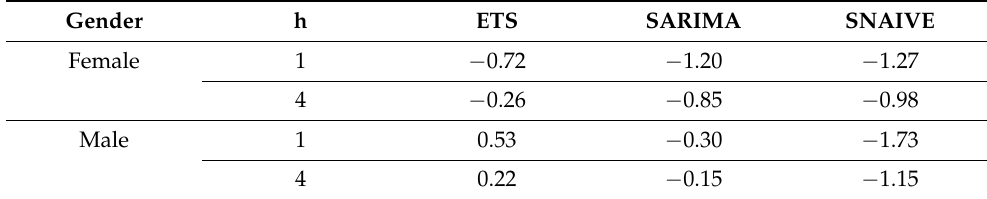
Table 10. Results of the modified Diebold–Mariano test comparing ITSA to ETS, SARIMA without intervention, and SNAIVE by